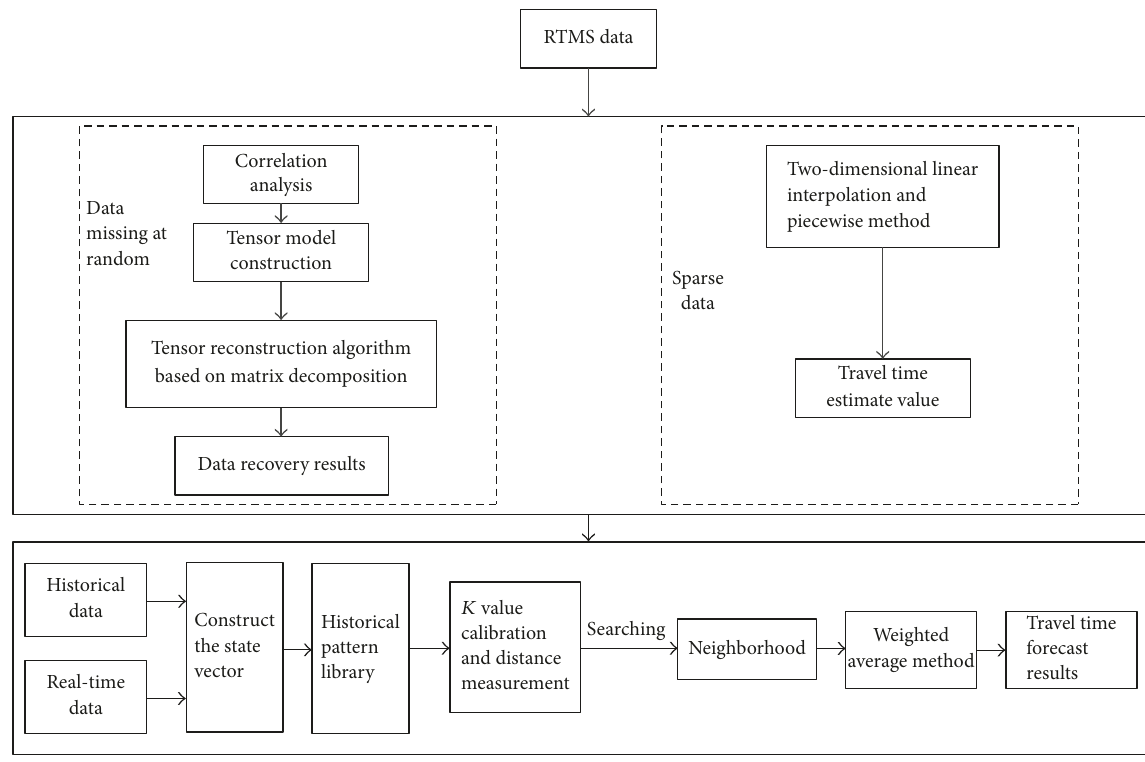
Figure 1: Framework of the